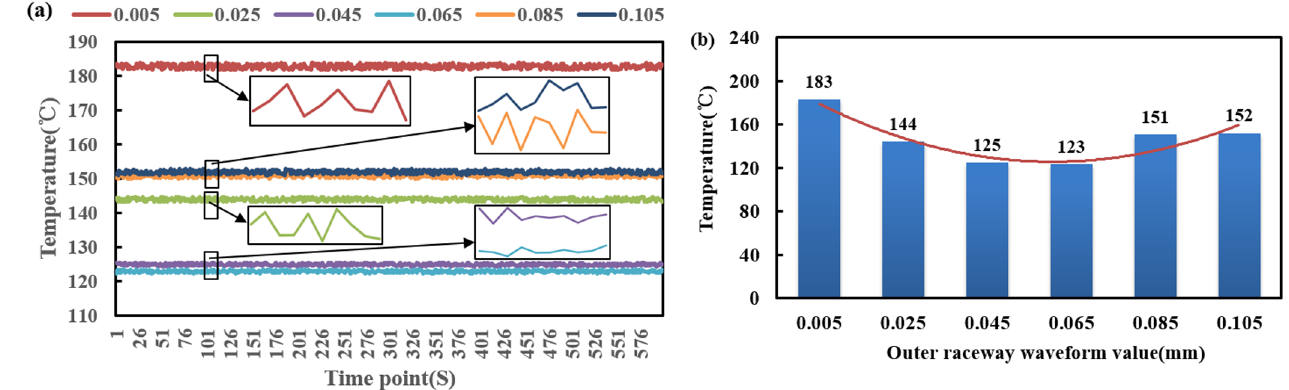
Fig. 15. Bearing temperature under the different outer raceway waveform values: (a) Time point temperature in the stable phase; (b)